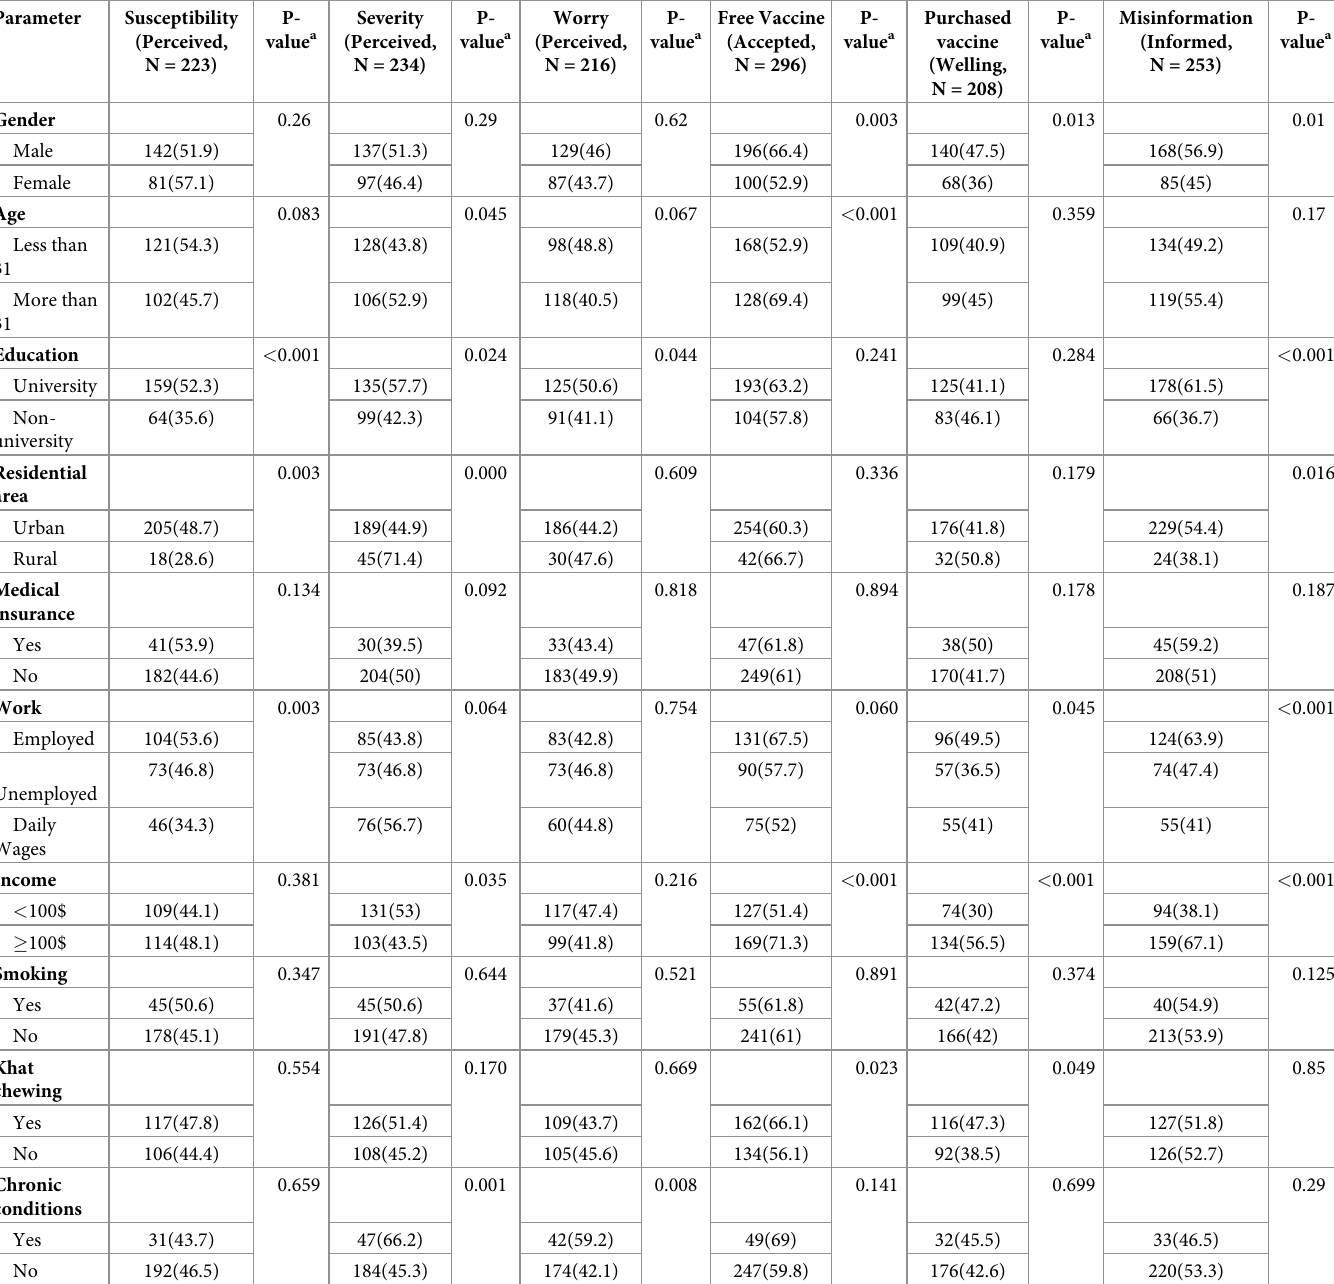
Table 4. Association between demographics and subjects’ perception, vaccine acceptance, and misinformation (n = 484).